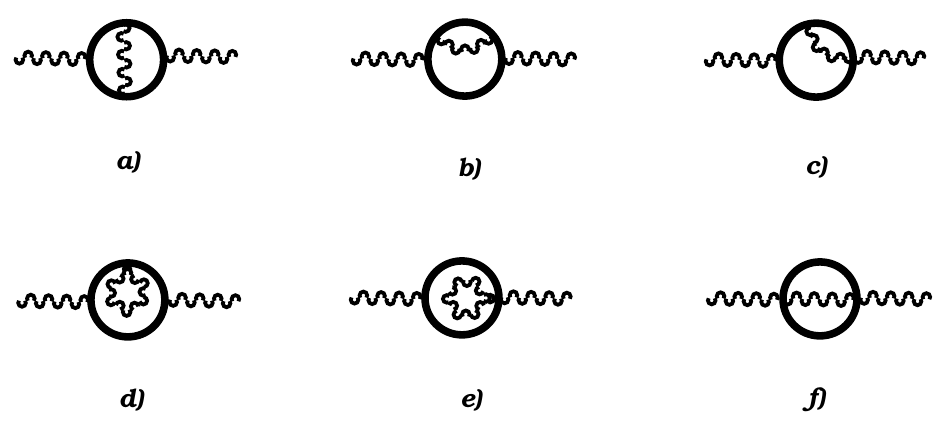
Figure 4 . Diagrams associated with the next order correction to the mean (cid:12)eld for S e(cid:11) . The combinatorial factors are a ) + 2 b ) (cid:0) 4 c ) (cid:0) d ) + e ) + f